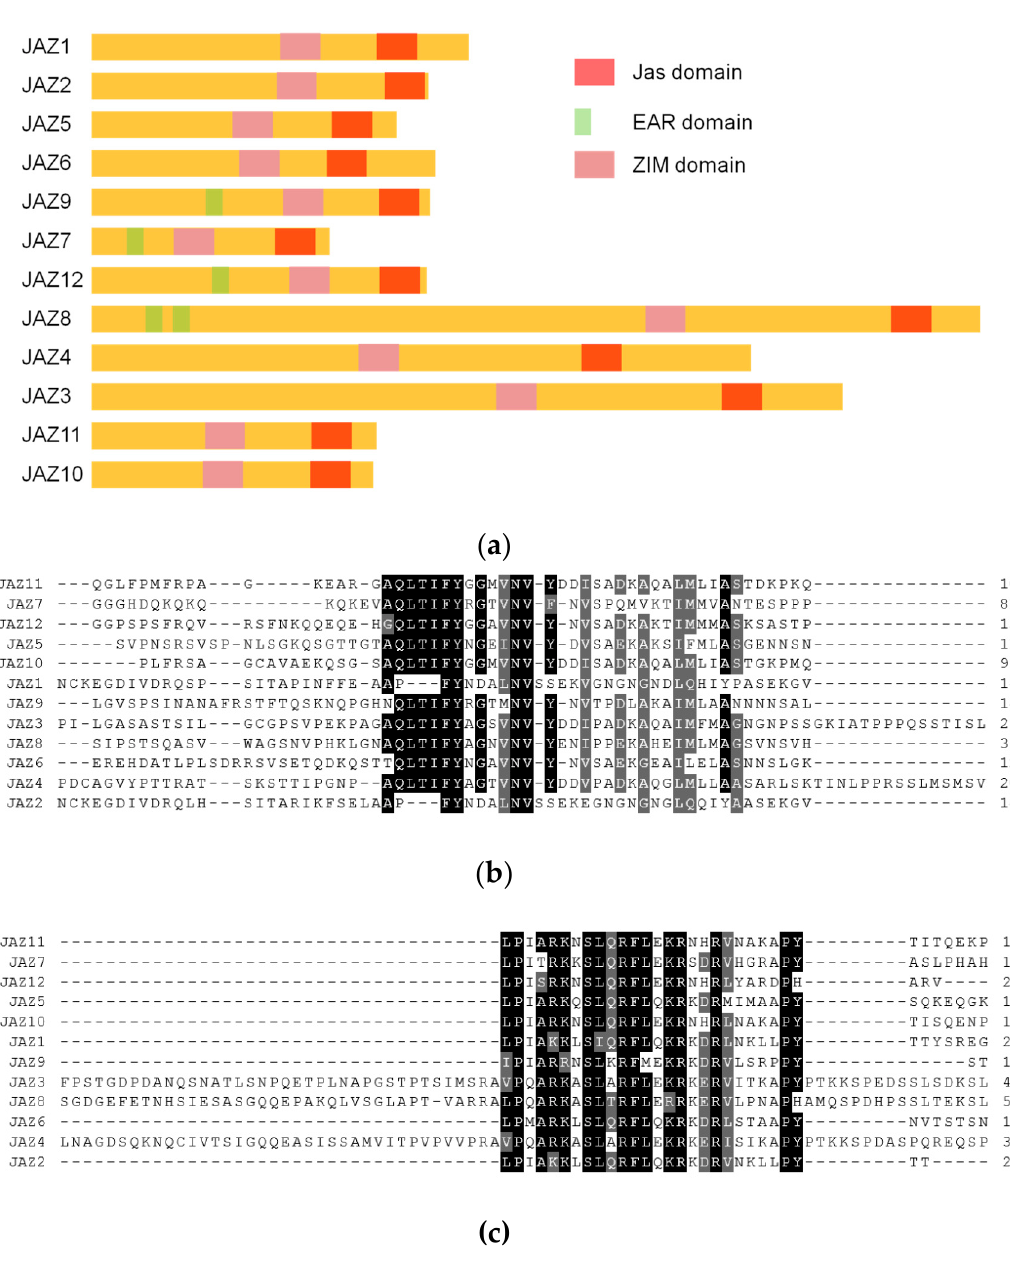
Figure 1. (a) schematic diagram of JAZ protein structure in T. media ; (b) JAZ protein ZIM domain Figure A1. ( a ) schematic diagram of JAZ protein structure in T. media ; ( b ) JAZ protein ZIM domain alignment map; (C) JAZ protein JAS domain alignment map in Taxus. alignment map; ( c ) JAZ protein JAS domain alignment map in Taxus